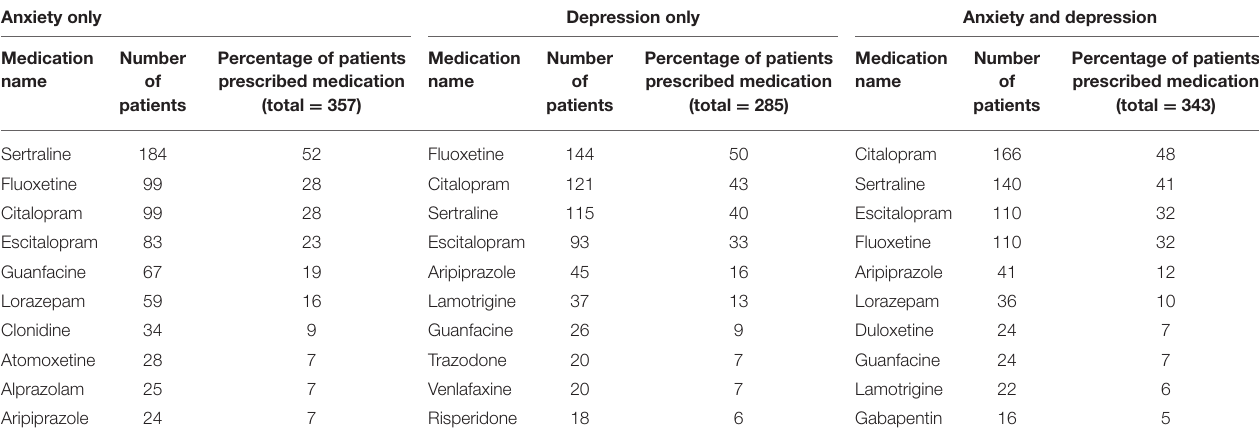
TABLE 2 | Most commonly used medications by diagnosis category. Anxiety only Depression only Anxiety and depression